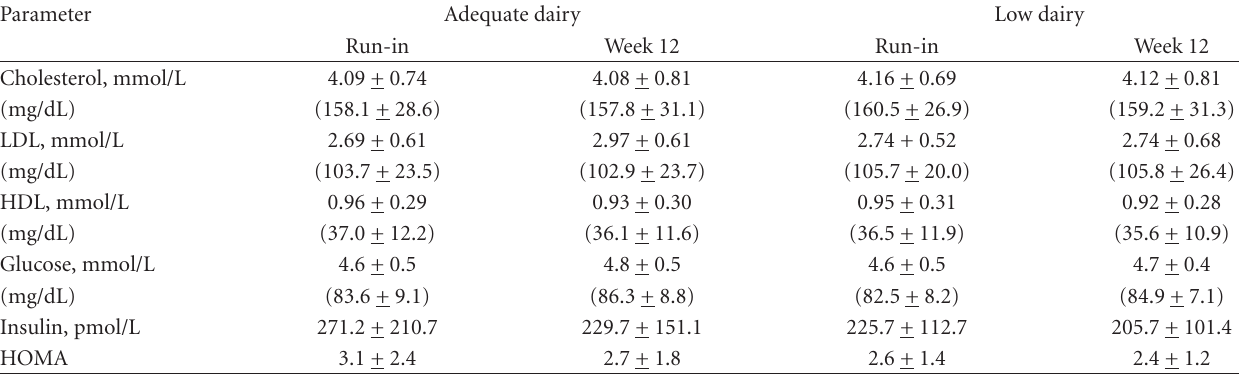
Table 8: Serum lipids, glucose, and insulin parameters in women and men consuming adequate dairy (AD) or low-dairy (LD) diets for 12 weeks.